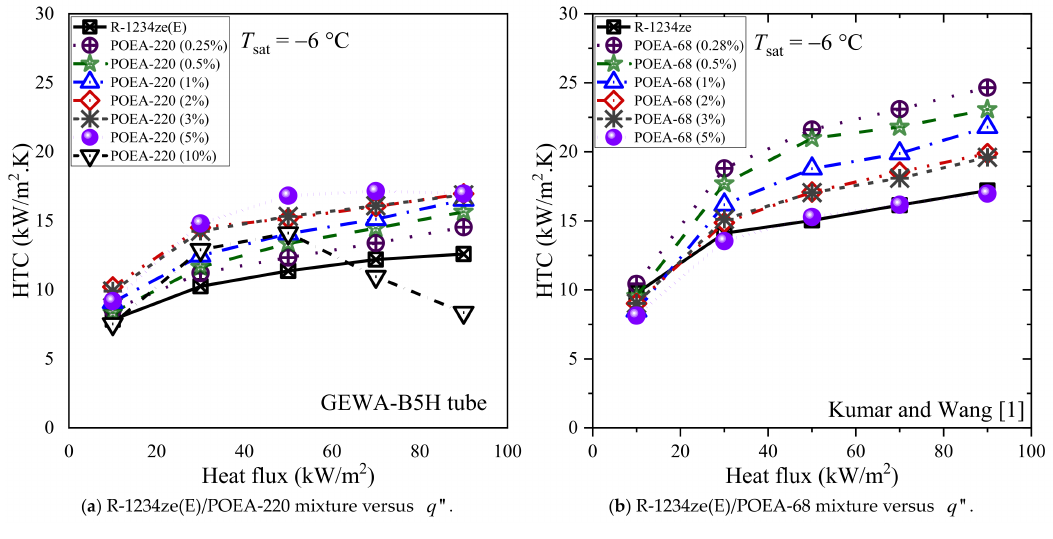
Figure 7. HTC versus q (cid:48)(cid:48) ( a ) R-1234ze(E)/POEA-220 ( b ) R-1234ze(E)/POEA-68 oil at − 6 ◦